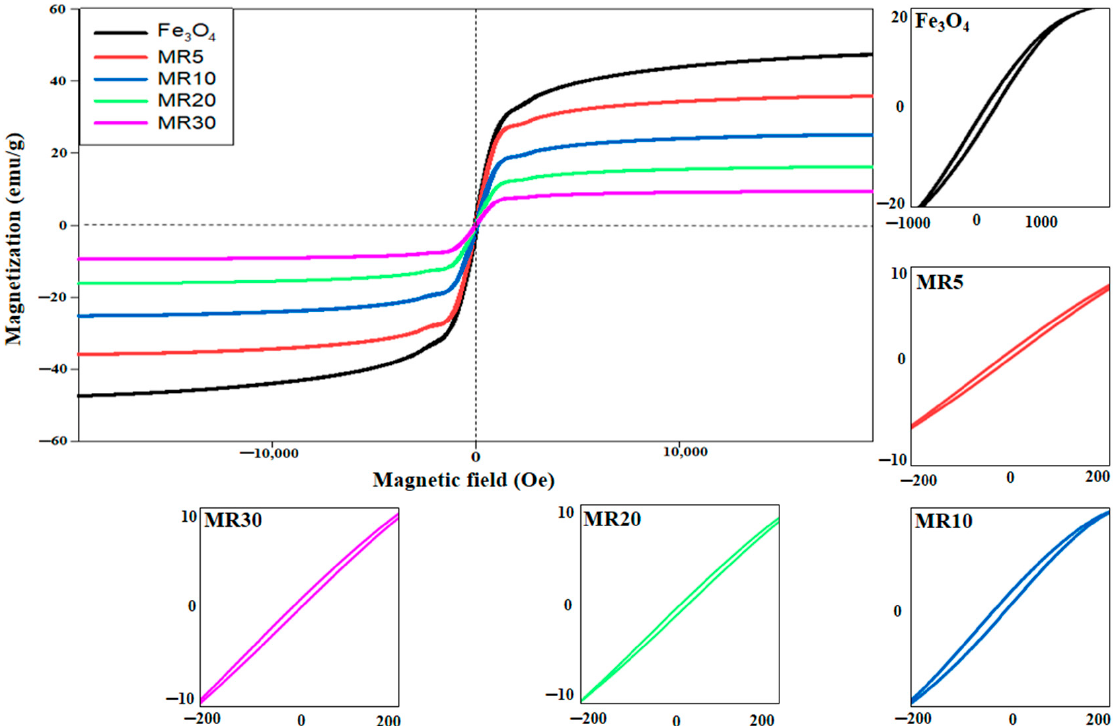
Figure 5. The hysteresis curves for Fe 3 O 4 , MR5, MR10, MR20, and MR30.